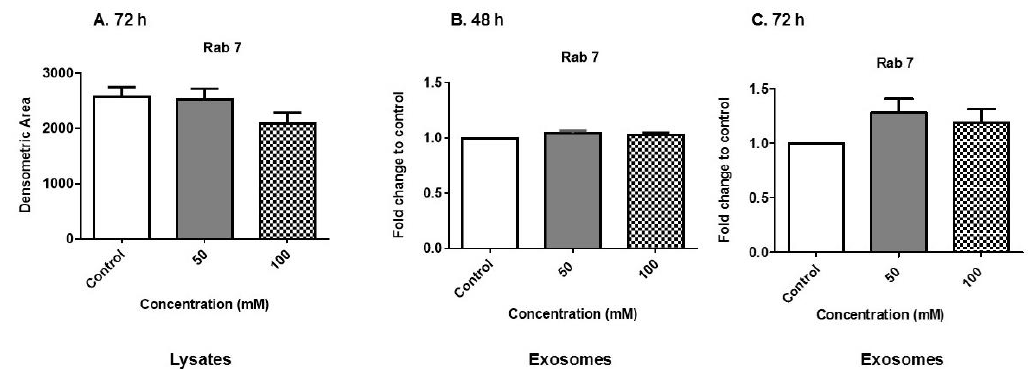
Figure 5. Expression of exosome biogenesis and secretory proteins. ( A ) Cell lysates (at 72 h EtOH administration) and ( B , C ) exosome proteins (at 48 and 72 h EtOH administration) were evaluated for Rab 7 expression. In order to obtain quantitative results, cell lysates were subjected to dot blot analysis and exosomes were subjected to ELISA. Experiments involving dot blot analysis and ELISA were performed with four to six independent replicates.